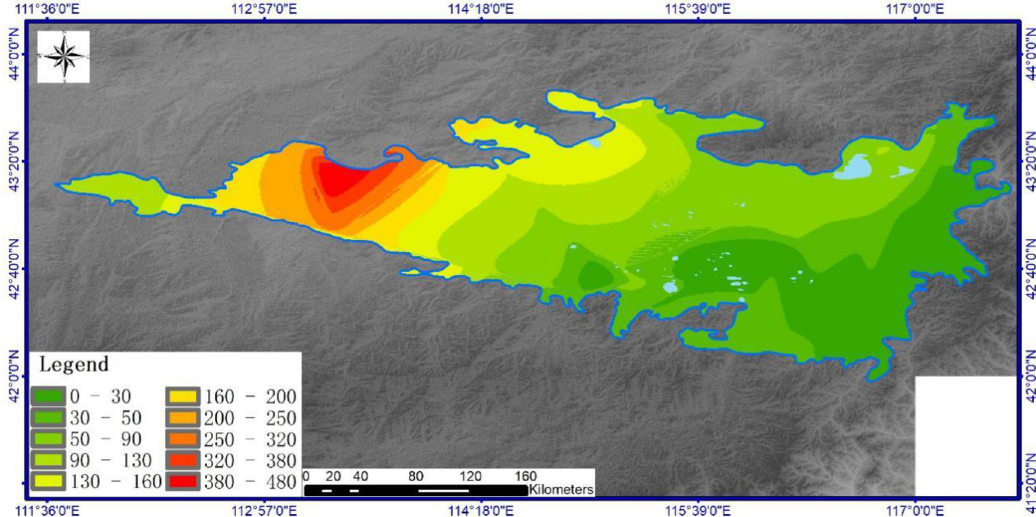
Fig 3. Spatial distribution of total base ions (mg/kg) in soils across Hunshandake sandy land(Cartographic software: Arcgis10.5).